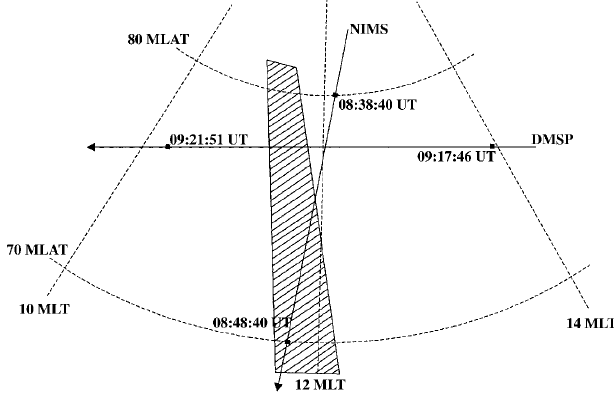
Fig. 6. Geometries of the NIMS satellite pass at 0845 UT and the DMSP pass at 0920 UT in a magnetic latitude versus MLT co- ordinate system. The trace for NIMS show the intersection of the satellite-to-receiver ray-paths with an altitude of 250 km. The trace for DMSP shows the track at satellite-height. The hatched area shows the viewing region of the MSP at 250 km and above 15 (cid:176) elevation between 0840 and